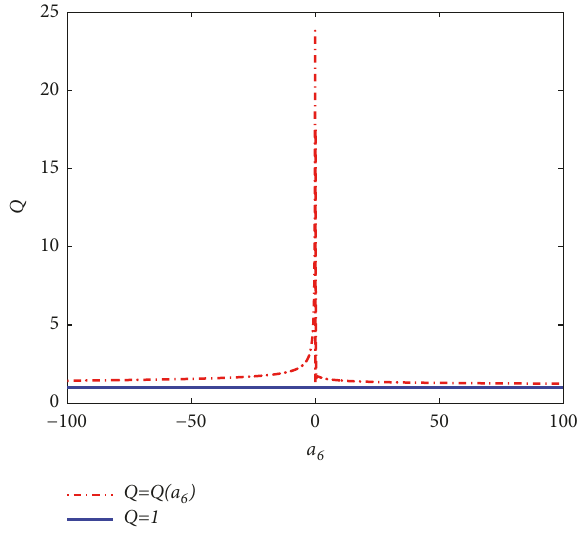
Figure 1: The graph of the moduli maximum function 𝑄(𝑎 6 )